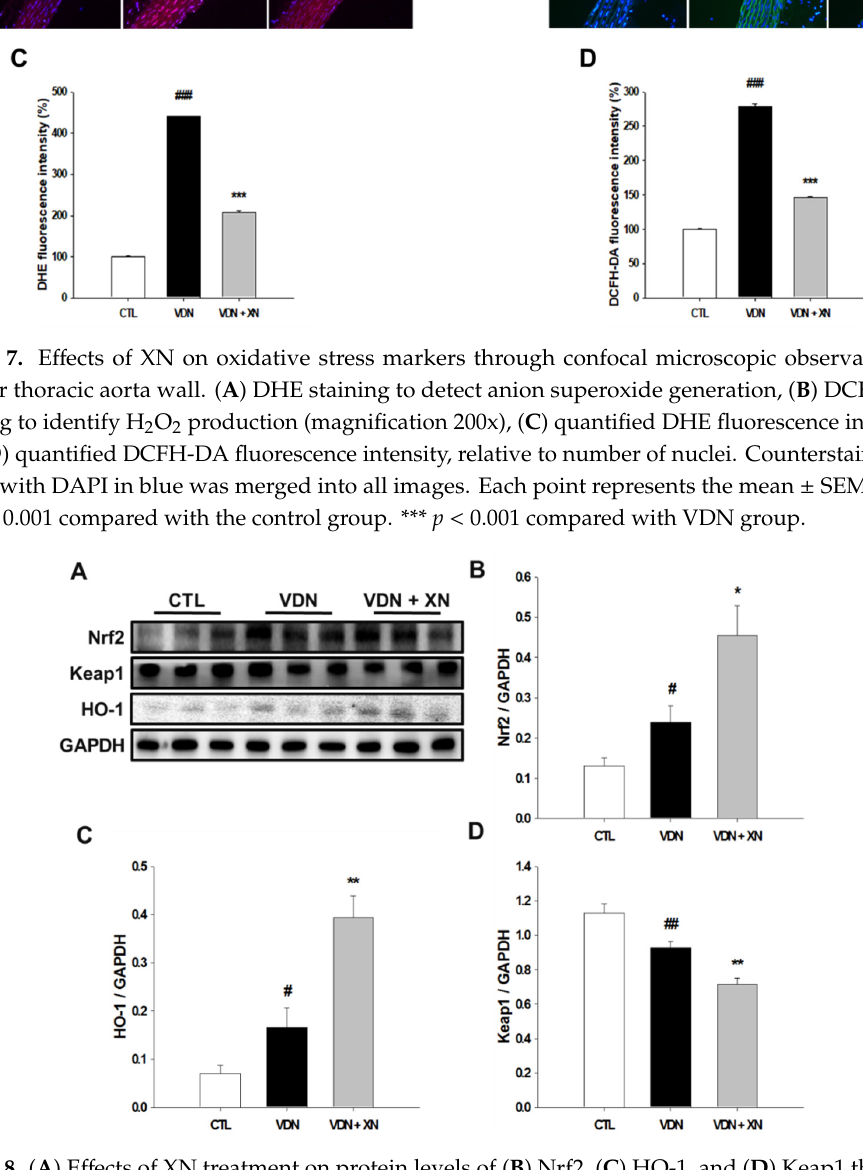
Figure 9. Effects of XN on the expressions of Nrf2, HO-1, and Keap1 through confocal microscopic evaluation of nuclear thoracic aorta wall. ( A ) Nrf2, ( B ) HO-1, ( C ) Keap1, ( D ) quantified Nrf2 fluorescence intensity, ( E ) quantified HO-1 fluorescence intensity, and ( F ) quantified Keap1 fluorescence intensity, relative to number of nuclei. Counterstaining of nuclei with DAPI in blue was merged into all images. Each